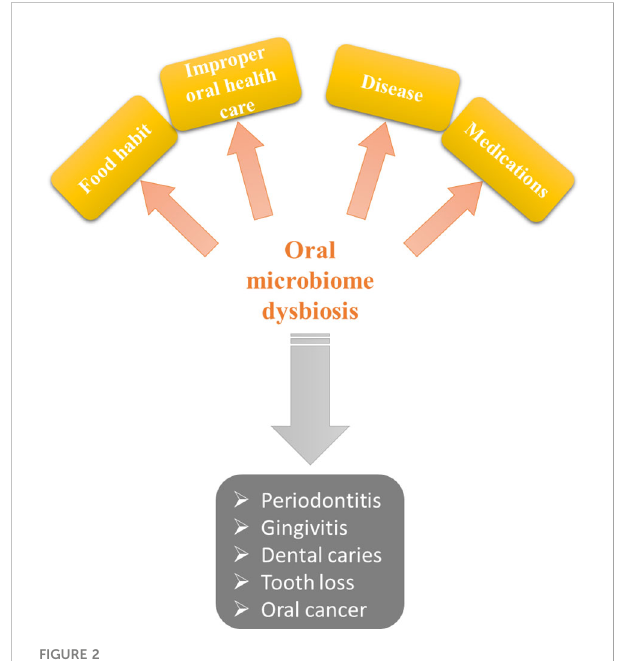
FIGURE 2 Pathogenicity of the oral microbiome in